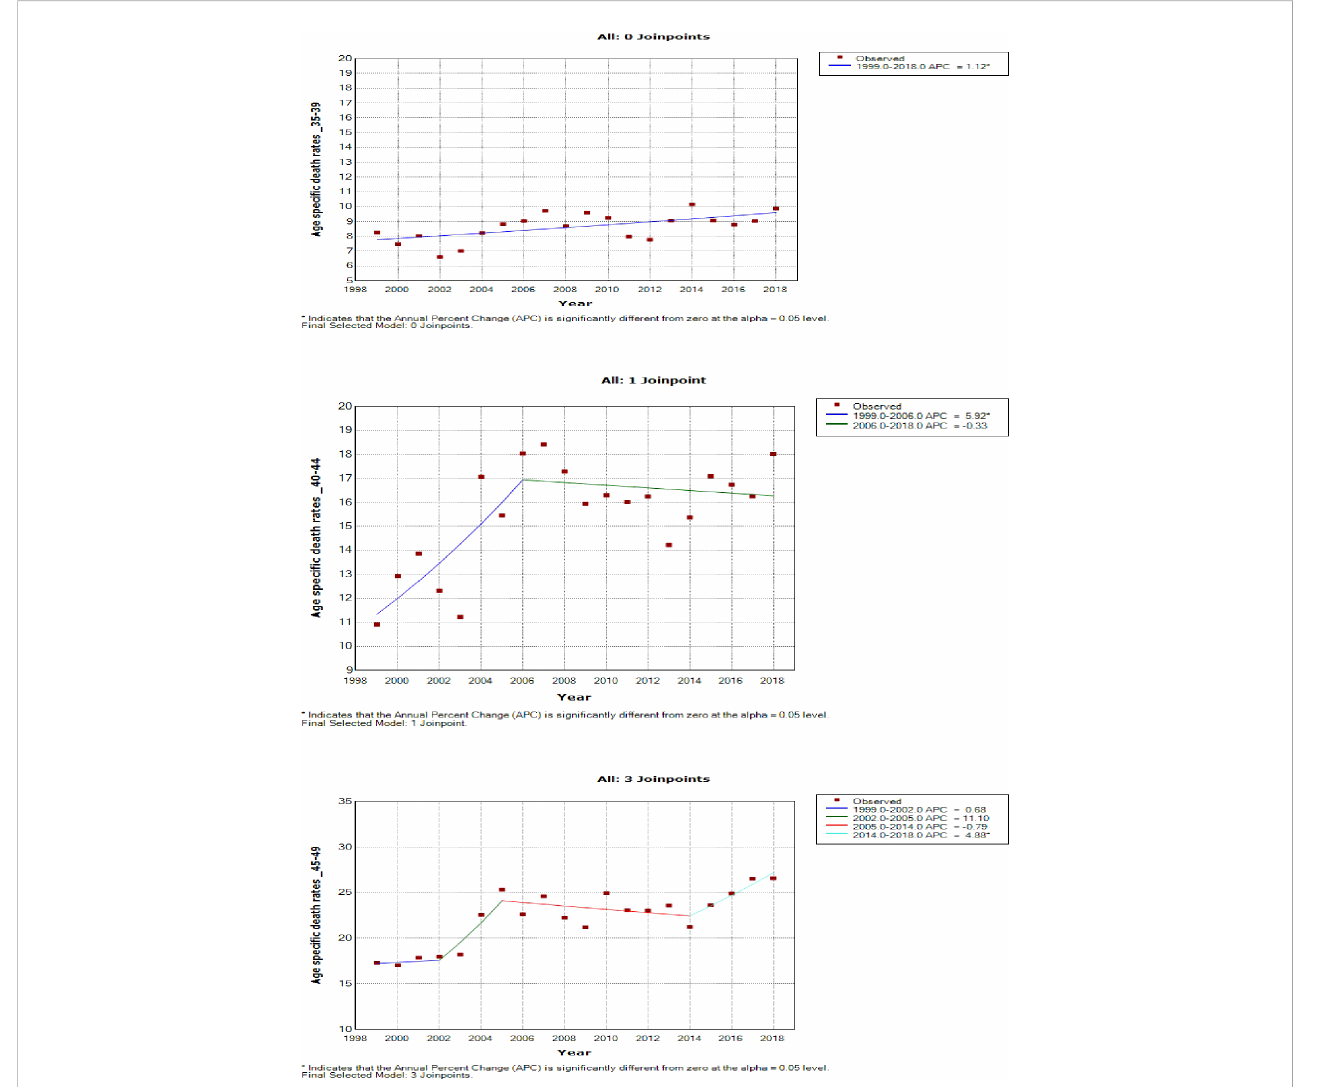
FIGURE 7 Joinpoint trends of age-speci fi c death rates of breast cancer in South Africa, 1999 – 2018, among 35 – 49-year-olds (5-year